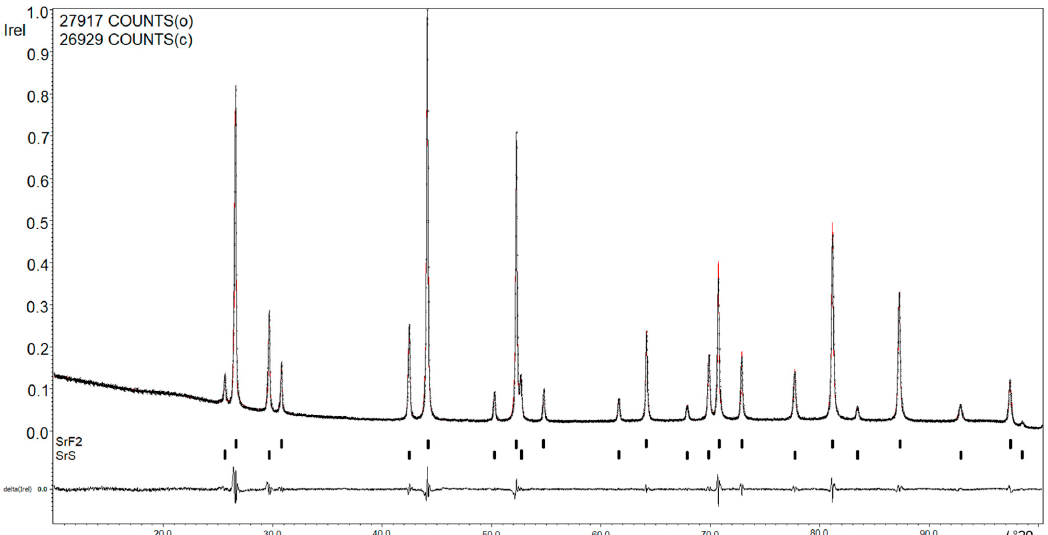
Figure 3. Le Bail fitting of the X-ray powder diffraction pattern of SrF 2 and SrS. The calculated reflection positions are represented by strokes below the observed and calculated powder pattern. The difference curves are plotted underneath. Profile R factors: R p = 3.16%, wR p = 4.40%, GOF = 1.72.